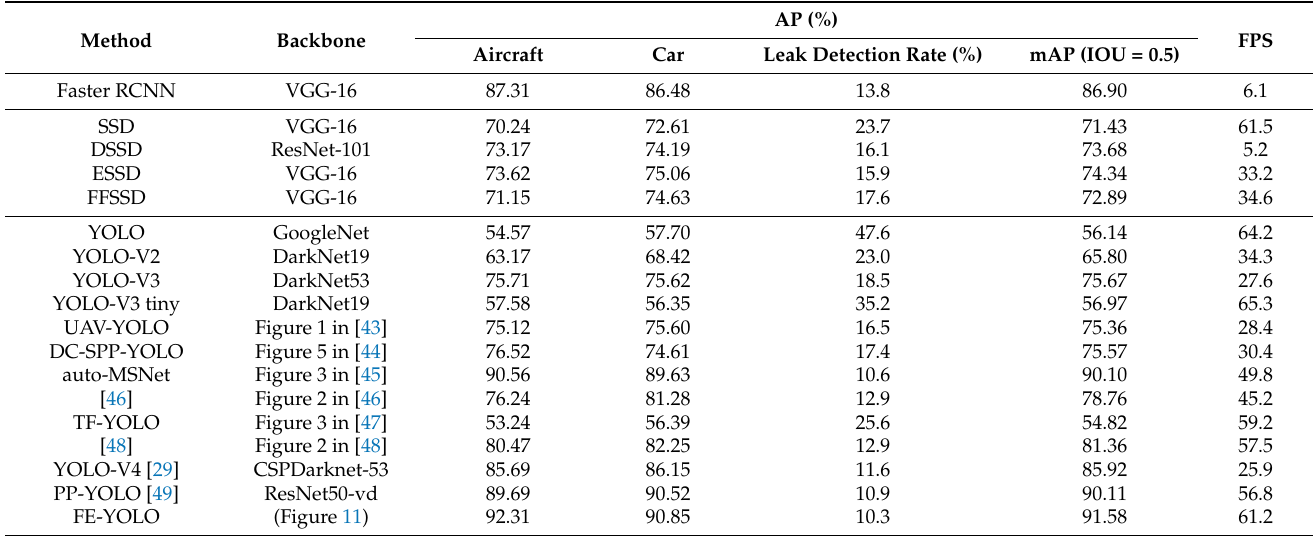
Table 10. Comparative results with the UCS-AOD